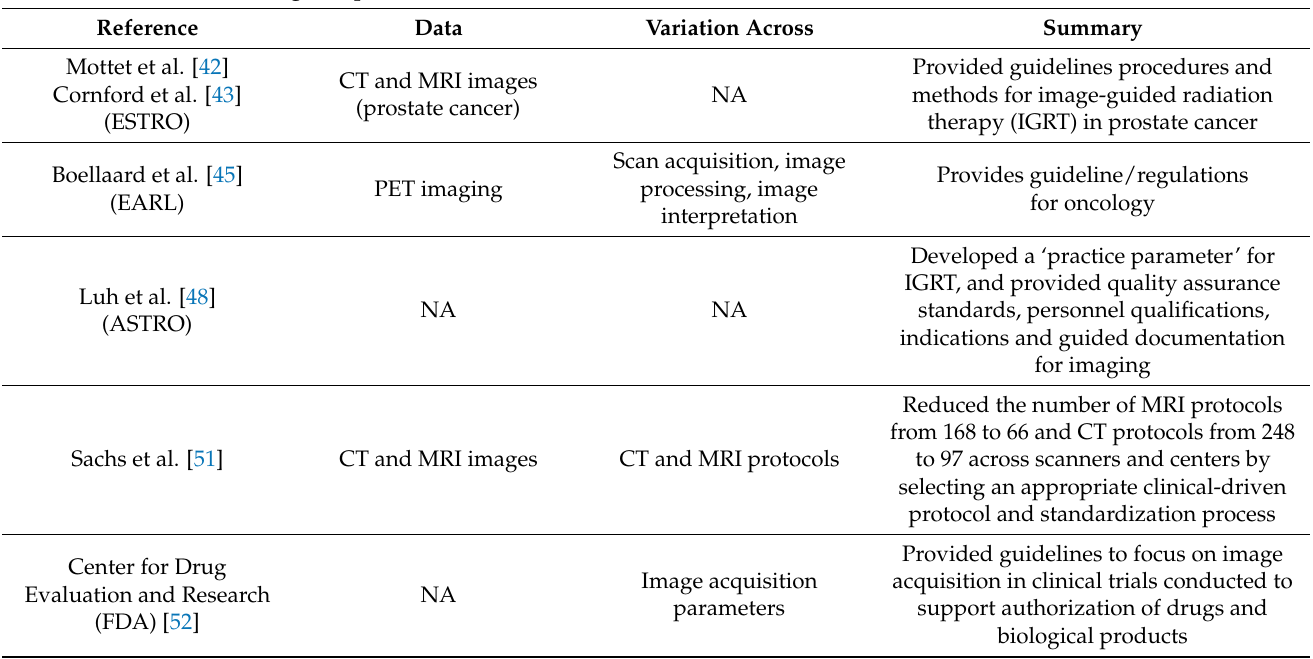
Table 1. Summary table of standardization guidelines/regulations set for image acquisition and reconstruction parameters across various